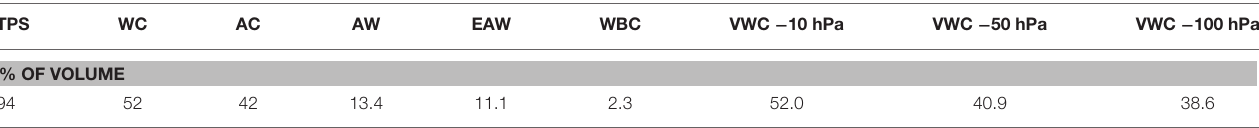
TABLE 1 | Physical properties of the growing medium used in the experiment (perlite:peat 3:1 v:v).